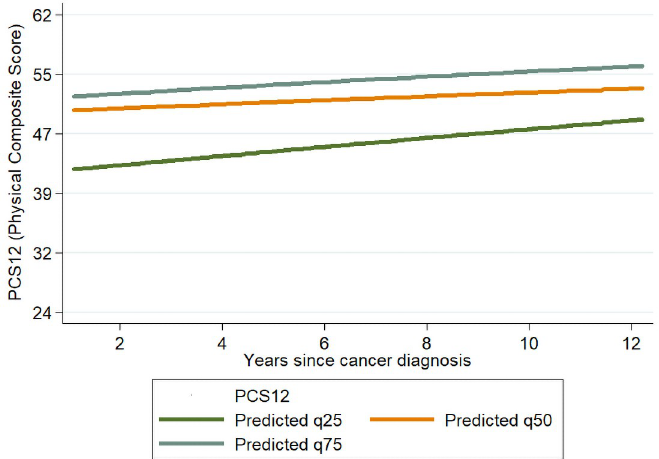
Fig 1. Scatterplot and line plot of predicted response for the 25 th , 50 th and 75th quantile for PCS in nonseminomas cases, on time between diagnosis and compilation of the questionnaire. The lines refer to a subject with all categorical variables set at the reference values and aged 40 years at compilation of the questionnaire.